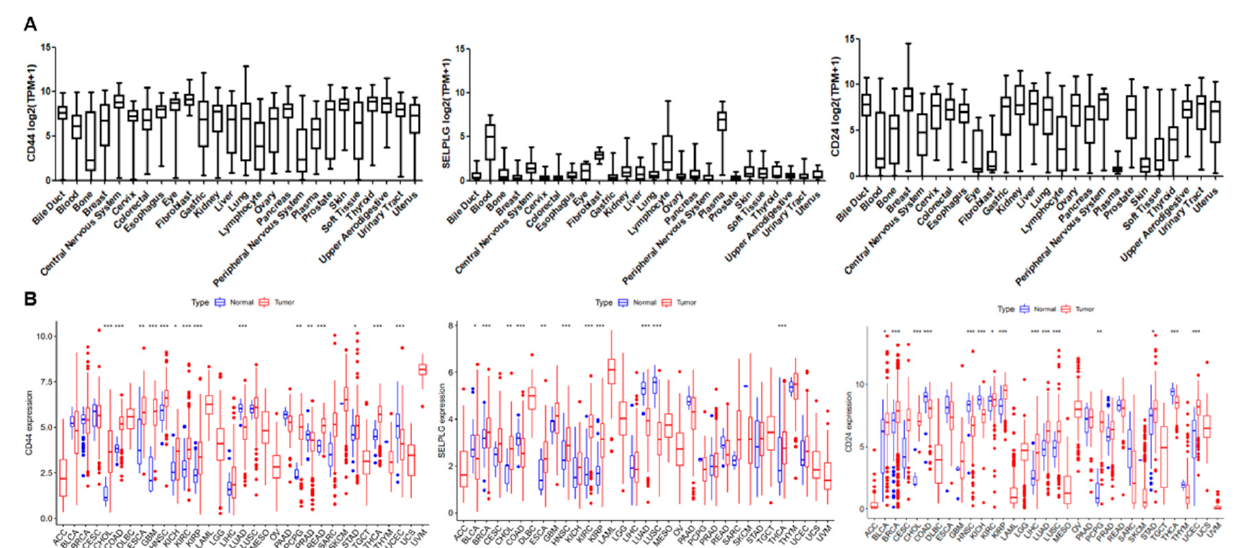
Figure 6. The mRNA expression of the ligands to the CD62P in the CCLE and TCGA database. ( A ). The mRNA expression levels of CD44, SELPLG, and CD24 in multiple cancer cell lines in the CCLE database. ( B ). The mRNA expression levels of CD44, SELPLG, and CD24 in multiple cancer types and corresponding normal tissues in TCGA database. * p < 0.05; ** p < 0.01; *** p < 0.001.